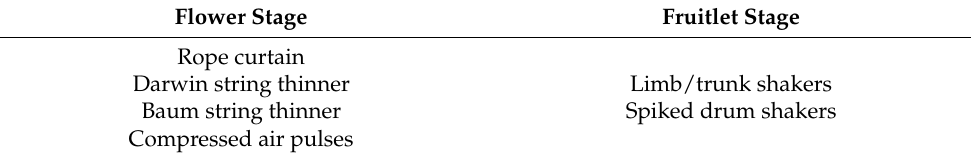
Table 3. Application time for different mechanical thinning